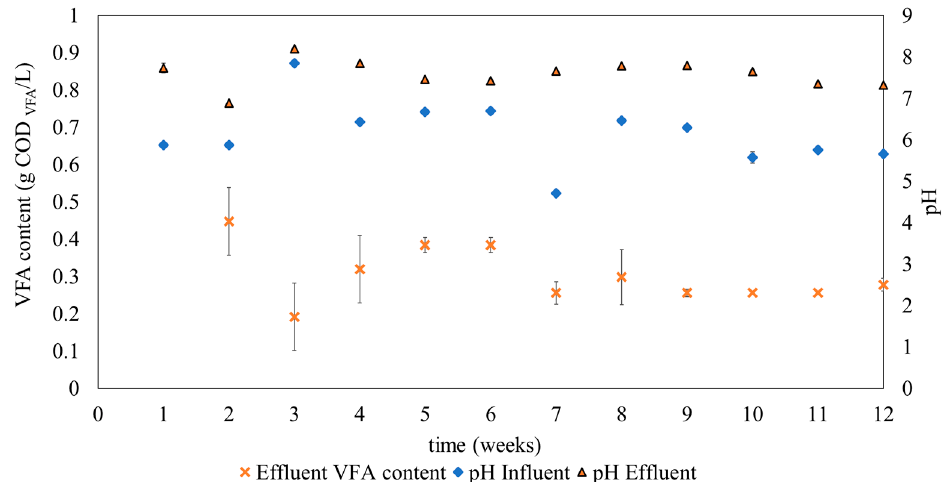
Figure 5. Effluent total volatile fatty acids concentration (orange cruxes) and influent and effluent pH (blue rhombus and orange triangles, respectively) during monitoring.